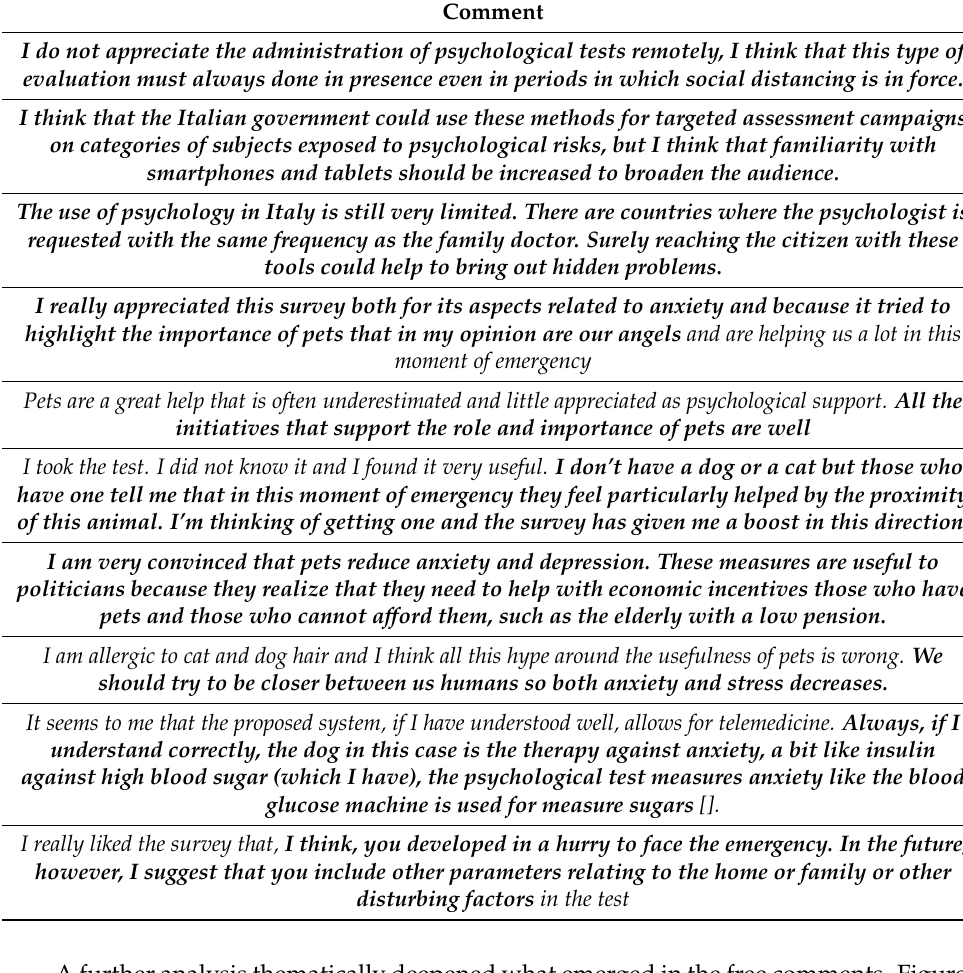
Figure 4. Averaged score for the different parameters proposed to assess the opinion of the partic- ipants.